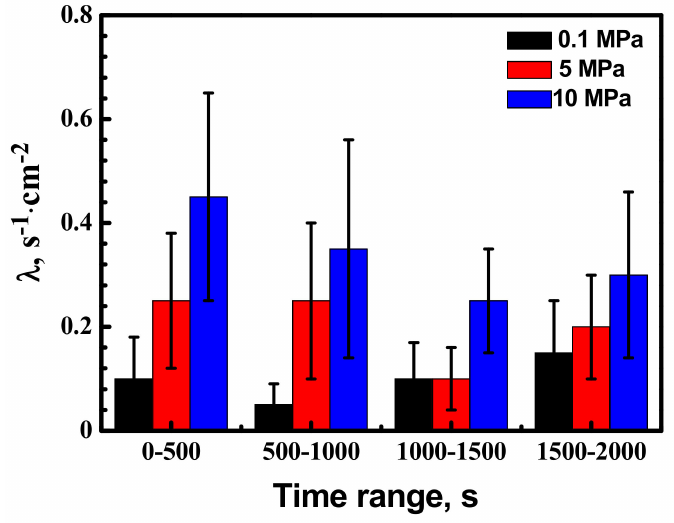
Figure 5. Metastable pit frequency in 0.5 mol/L NaHCO 3 + 0.1 mol/L NaCl aqueous solution for the X70 steel at various hydrostatic pressure and − 100 mV vs. Ag/AgCl